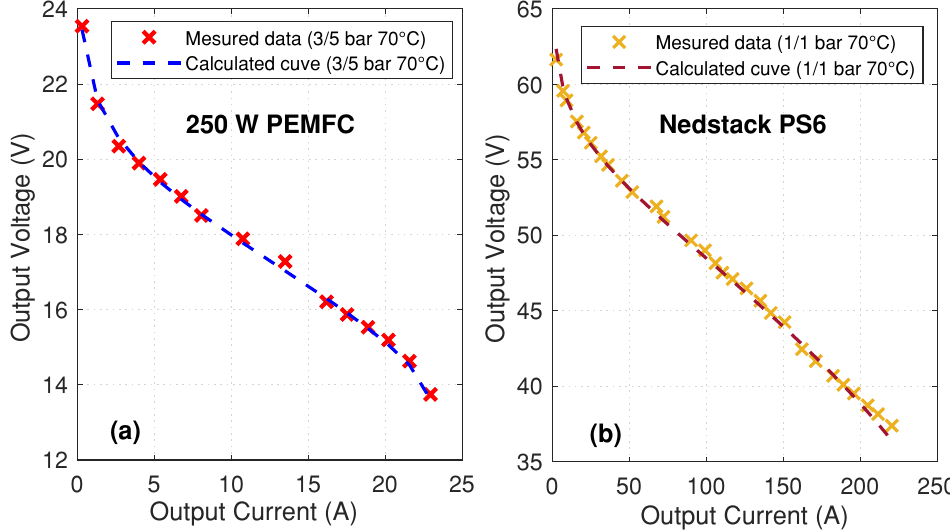
Figure 6. The current–voltage curve: ( a ) 250 W fuel cel; ( b ) NedStack PS6 fuel